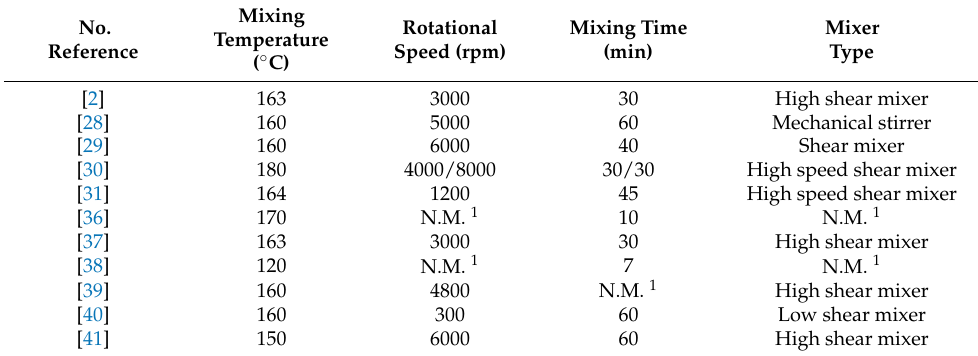
Table 3. Mixing conditions of bitumen with lignin by literature